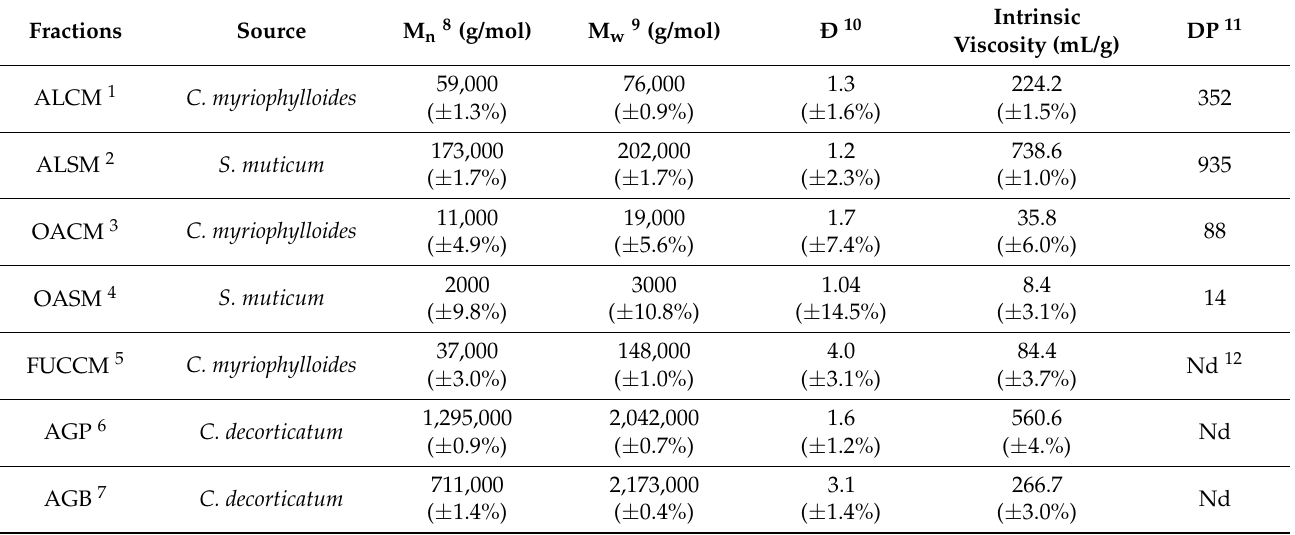
Table 2. Average molecular weight determination and DPs distribution of extracted